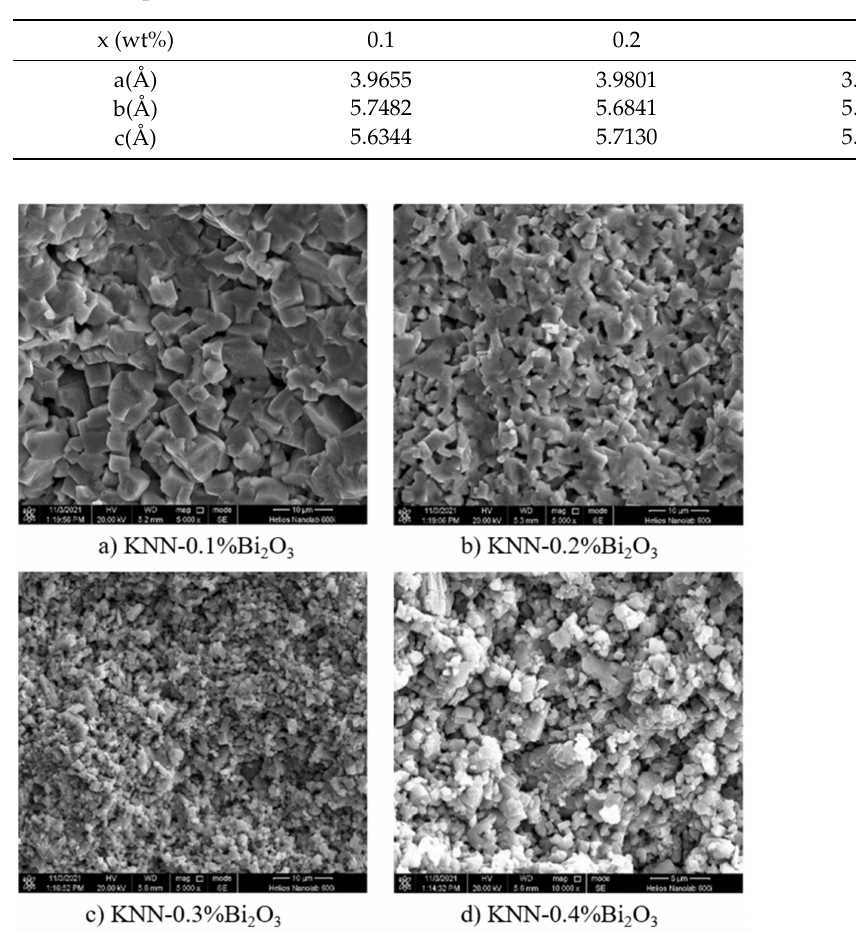
Figure 1. XRD pattern of KNN-xBi 2 O 3 piezoelectric ceramics. Table 1. Cell parameters of KNN-x%Bi2O3(x = 0.0, 0.1, 0.2, 0.3) ceramics.